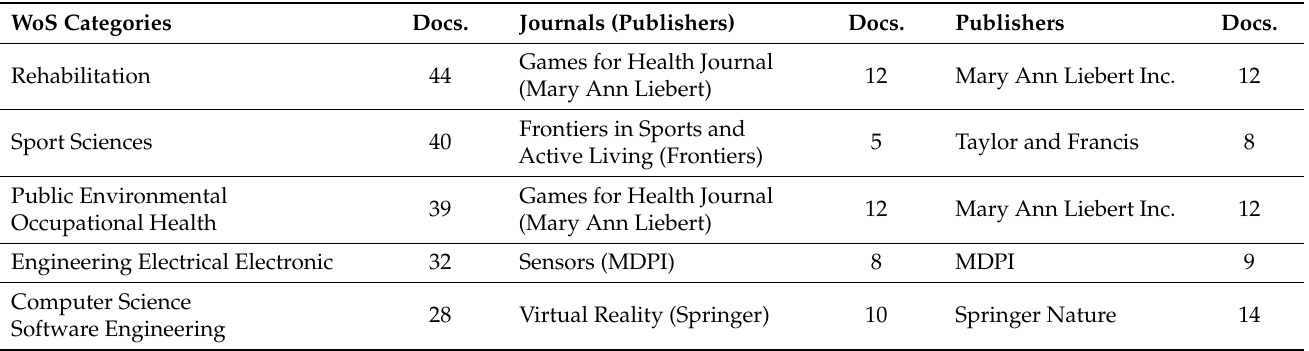
Table 1. Top five thematic categories in the Web of Science, according to the number of documents in which publications were indexed.